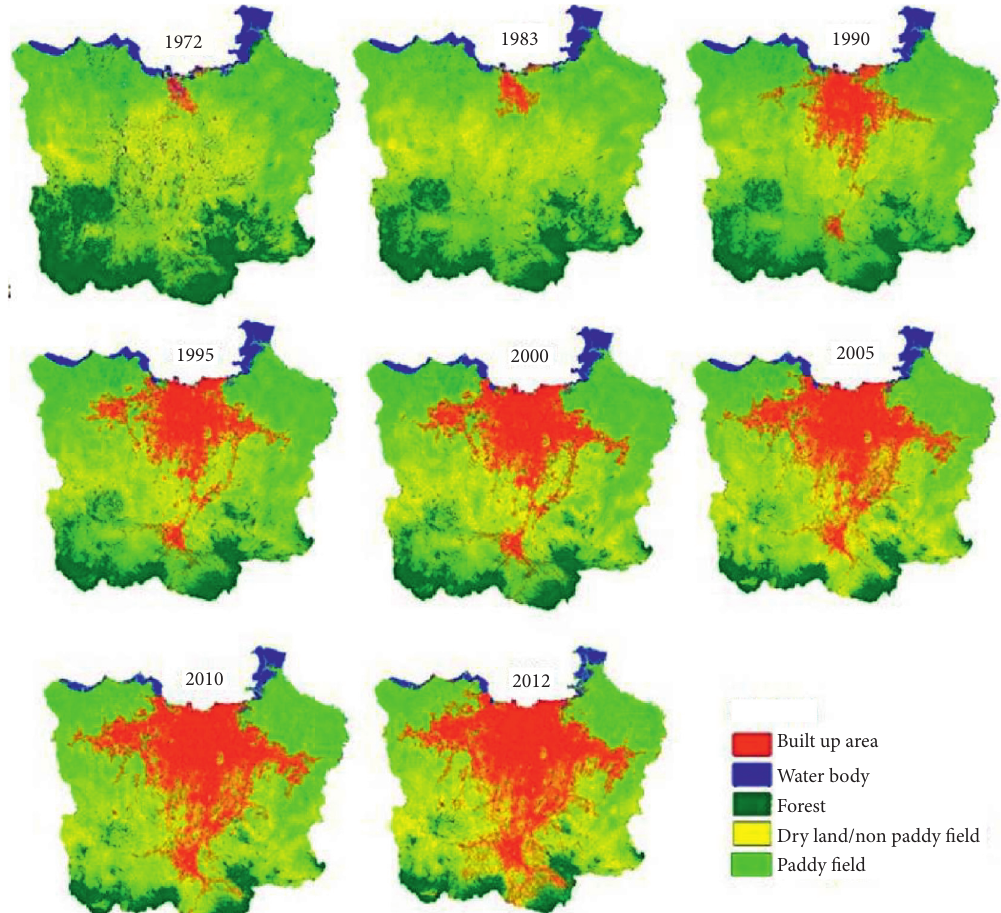
Figure 2: The map of land use/cover change in Jabodetabek in 1972–2012 (source: Rustiadi et al.